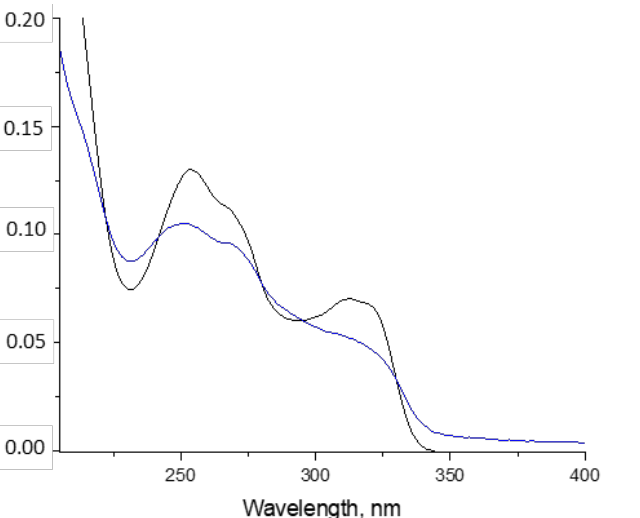
Figure 3. Absorption spectra of complexes Tb • 5g (black line) and Tb • 4g (blue line) in water at room temperature.